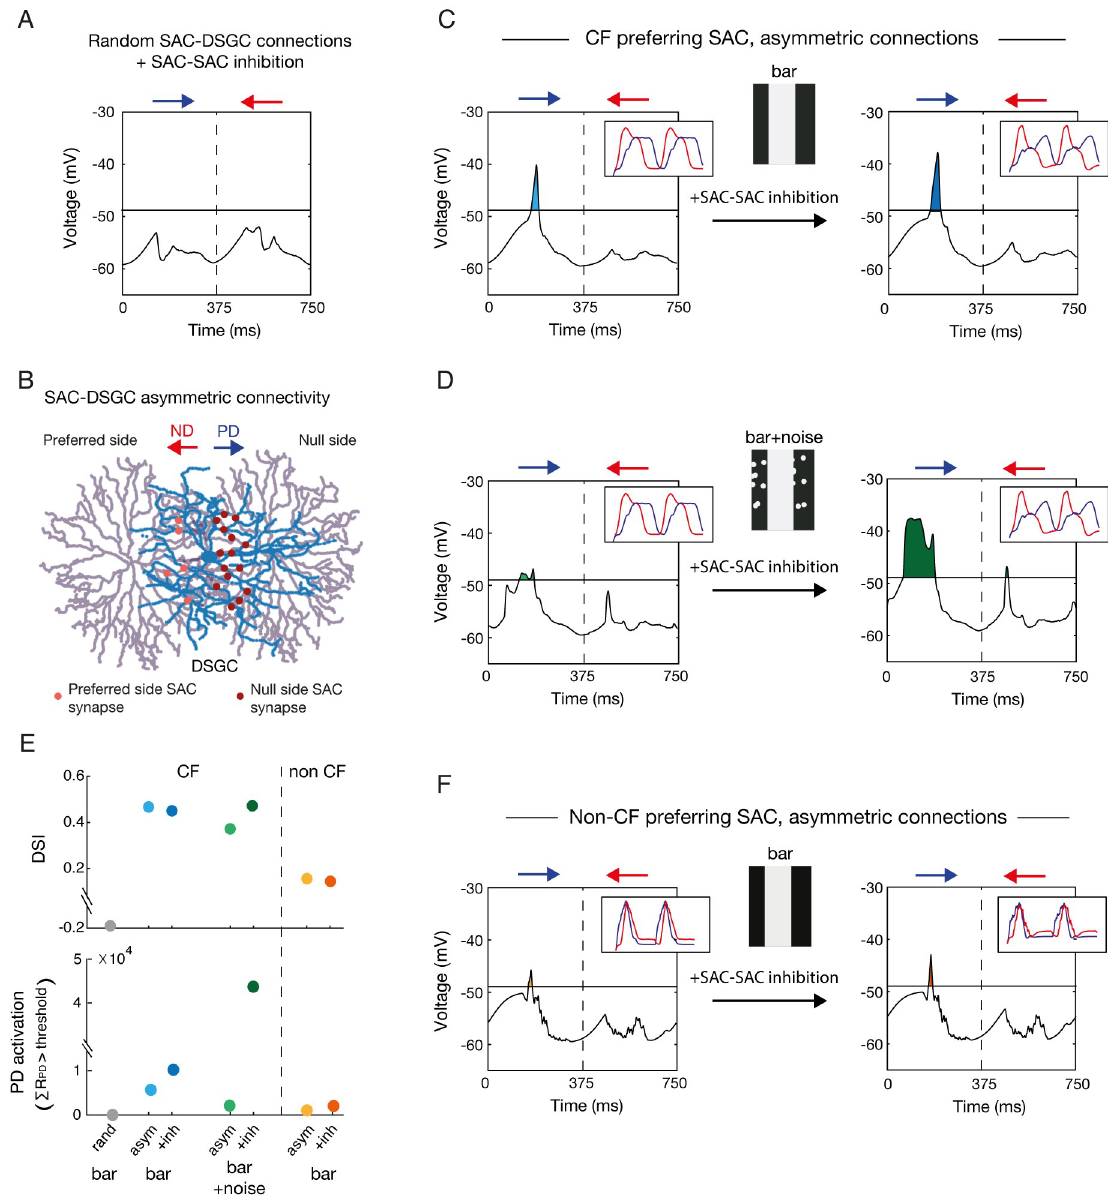
Fig 6. Asymmetric SAC-DSGC connections are required for DSGC’s direction selectivity. A. A DSGC was randomly connected to a network of CF-preferring SACs ( Fig 5A ) and consecutively presented with a bar moving in the preferred (PD, blue) and null directions (ND, red), twice in a row. Voltage traces represent the DSGC’s somatic voltage during the 2 nd stimulation cycle. Horizontal line represents the threshold for spiking (-49mV; see S9 Fig). B. Schematic of two SACs (purple) forming asymmetric GABAergic synapses (red) onto a DSGC (blue). SAC-DSGC synapses were defined with higher probability when the SAC’s process and the DSGC’s PD were antiparallel. C. The response of the simulated DSGC when connected to the SAC network following the asymmetric connectivity rule, in the absence (left) and presence (right) of reciprocal inhibition between SACs. Insets represent the SAC waveforms to expanding and collapsing rings in each condition. D. Same as C but when random noise was added to the background of the visual stimulus. E. The direction selective index (DSI) and PD activation calculated from the above simulations. The DSI is calculated according to the area under the voltage waveform (baseline to trace), PD activation is calculated as the area above spiking threshold during preferred direction motion (see Methods ). F. Same as C but for a non-CF SAC